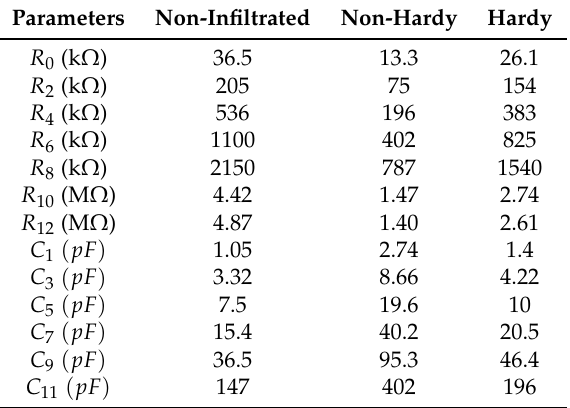
Table 3. Values of resistors and capacitors of the Type-I Cauer network for implementing the membrane impedance model of the cases in Table 2.